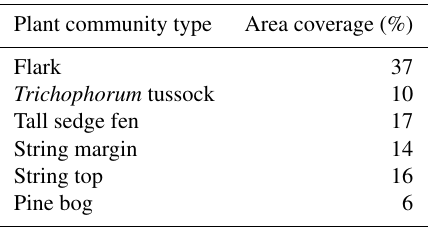
Table 2. Area coverage of the plant community types of the peat- land inside a 200m radius around the eddy covariance tower.